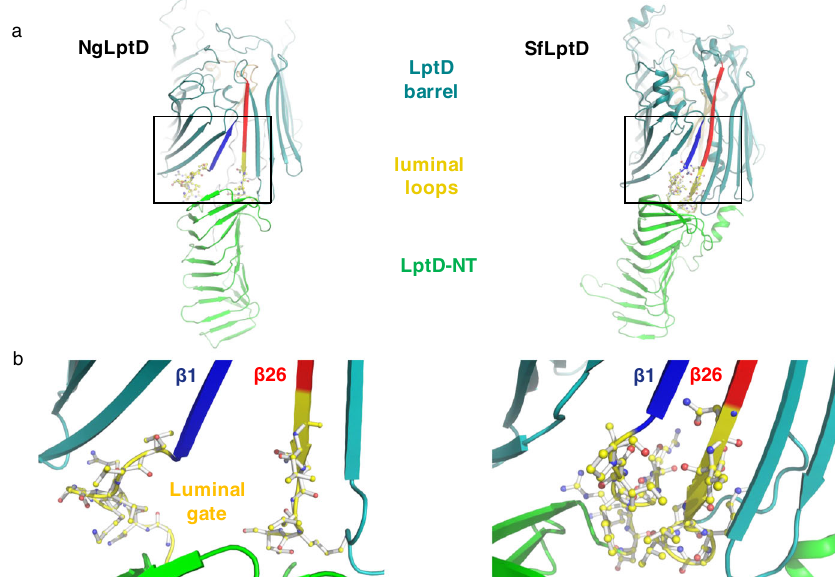
Fig. 3 The luminal gate in structures of NgLptDE and SfLptDE. a The luminal turns (yellow) of NglptDE (left) are separated by more than 3 Å, leading to a continuous groove between the LptD barrel and the hydrophobic groove of the N-terminal domain. In SfLptDE (PDB-ID 4Q35) (right), the luminal turns obstruct the luminal gate. b Enlarged view of the luminal gates of NgLptDE (left) and SfLptDE (right). The fi rst ( β 1) and last ( β 26) strands of the LptD barrels are shown in blue and red, respectively.